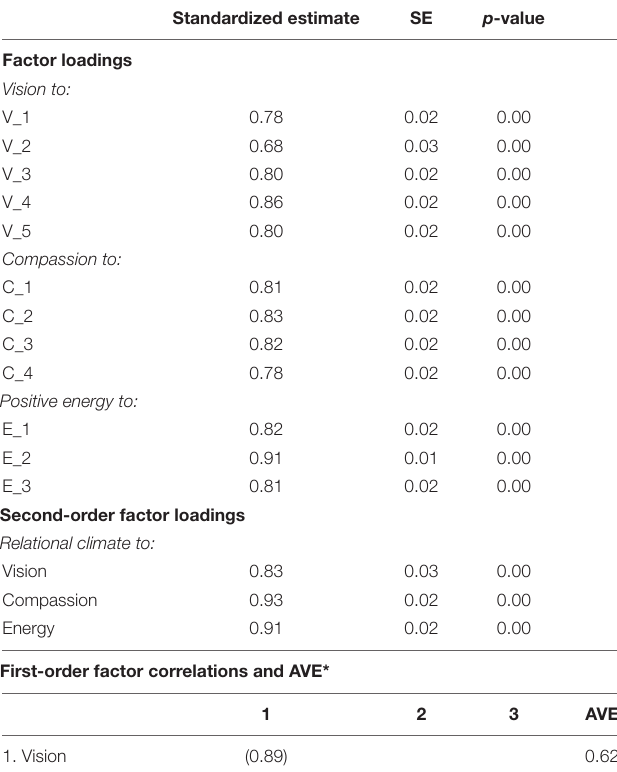
TABLE 7 | Model 1: Measurement model factor loadings (Sample